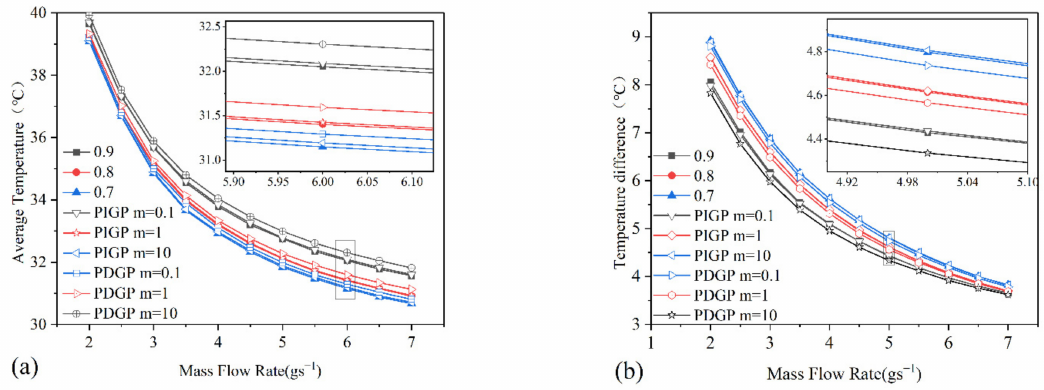
Figure 13. ( a ) Average temperature of battery, ( b ) temperature difference of battery (with AFHS with gradient porosity designed in the Z -axis direction).